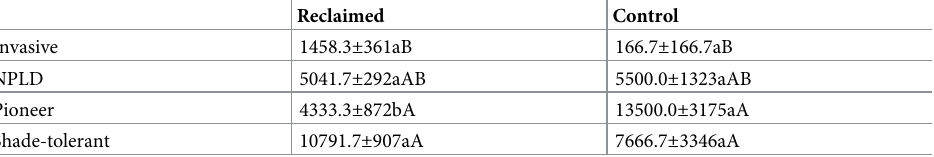
Means followed by different lower case letters show significant differences between control and reclaimed sites while means followed by different upper case letters in the same column show significant differences between guild